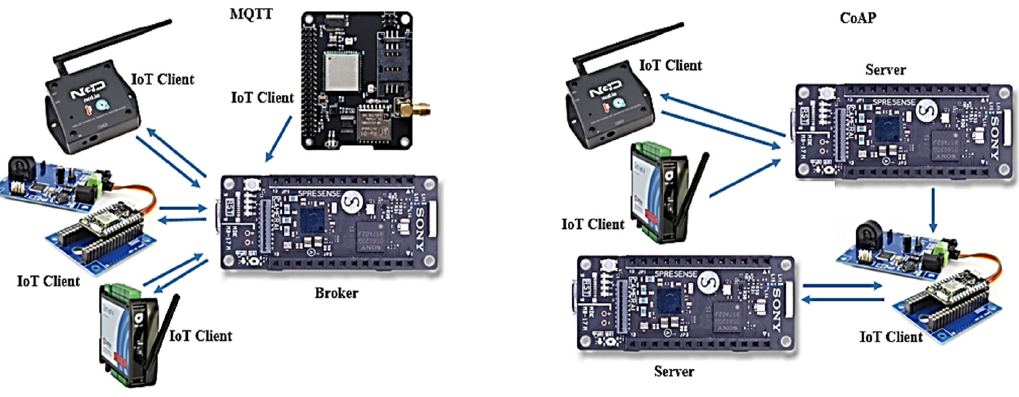
Figure 1. IoT communication protocols—MQTT and CoAP.